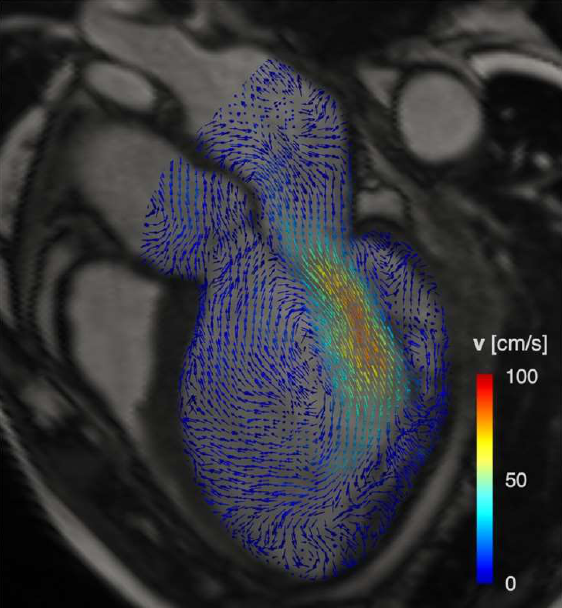
Figure 3. A color-coded 4D flow vector map at mid-diastole demonstrates the intracavitary flow with the generation of a large mid-ventricular vortex in patients with post-ischemic LV